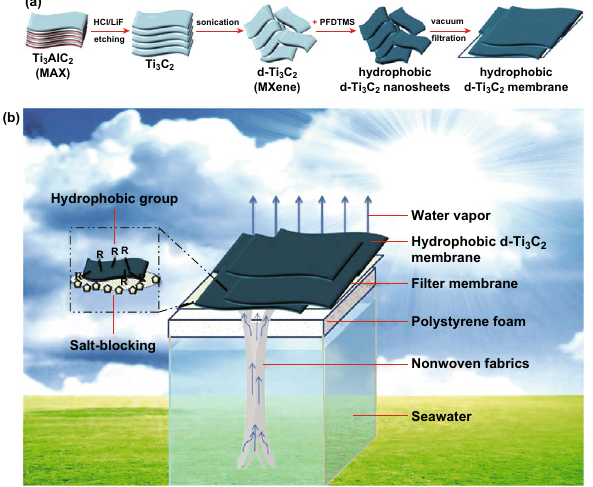
Fig. 13 Schematic illustration of a fabrication process of the hydro- phobic d-Ti 3 C 2 membrane, and b the hydrophobic d-Ti 3 C 2 membrane- based solar desalination device. Reprinted with permission from Ref.